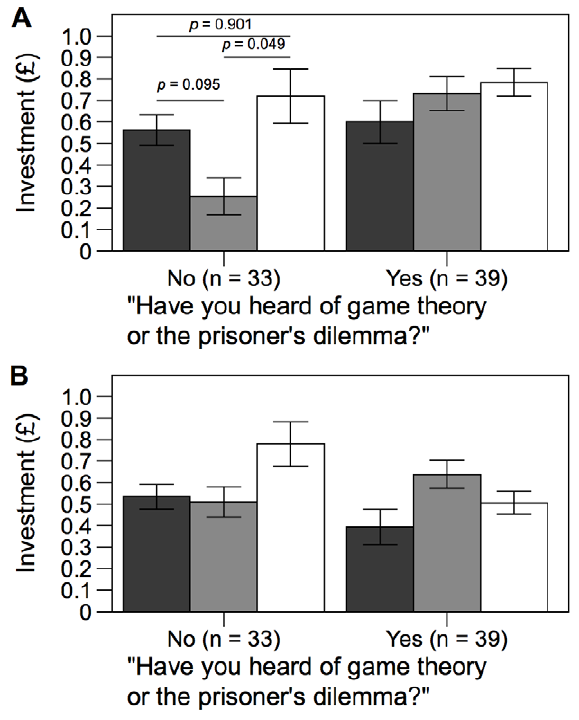
Figure 3. Investment in the public goods game. a) In round 3, investment levels were constant across the three conditions among participants who had heard of game theory, but varied across conditions among participants who had not heard of game theory (F 1,65 =3.83, p =0.027). All pairwise comparisons of conditions among participants who had heard of game theory were non-significant ( p . 0.6). b) Average investment in round 4 and 5. Investment did not differ between M, T1 and T2 conditions among participants who were unfamilar with game theory, nor between participants who were familiar with game theory ( p . 0.3). Bars show mean 6 standard error; black bars show M condition, grey bars T1 and white bars T2. p -values for pairwise comparisons are from Tukey post-hoc tests.